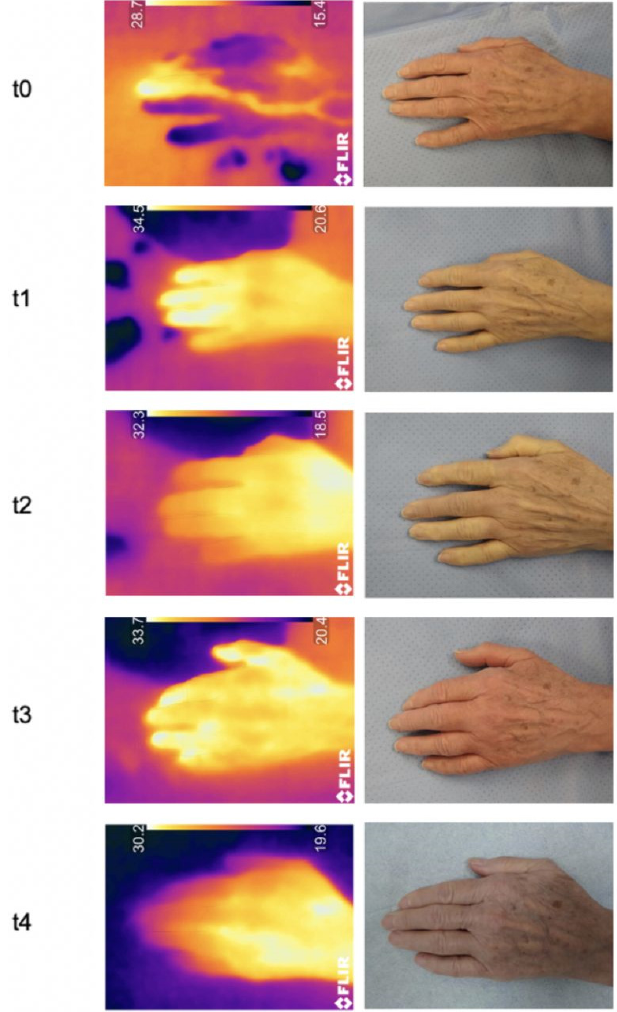
Figure 7. Skin temperature of a patient´s hand at different